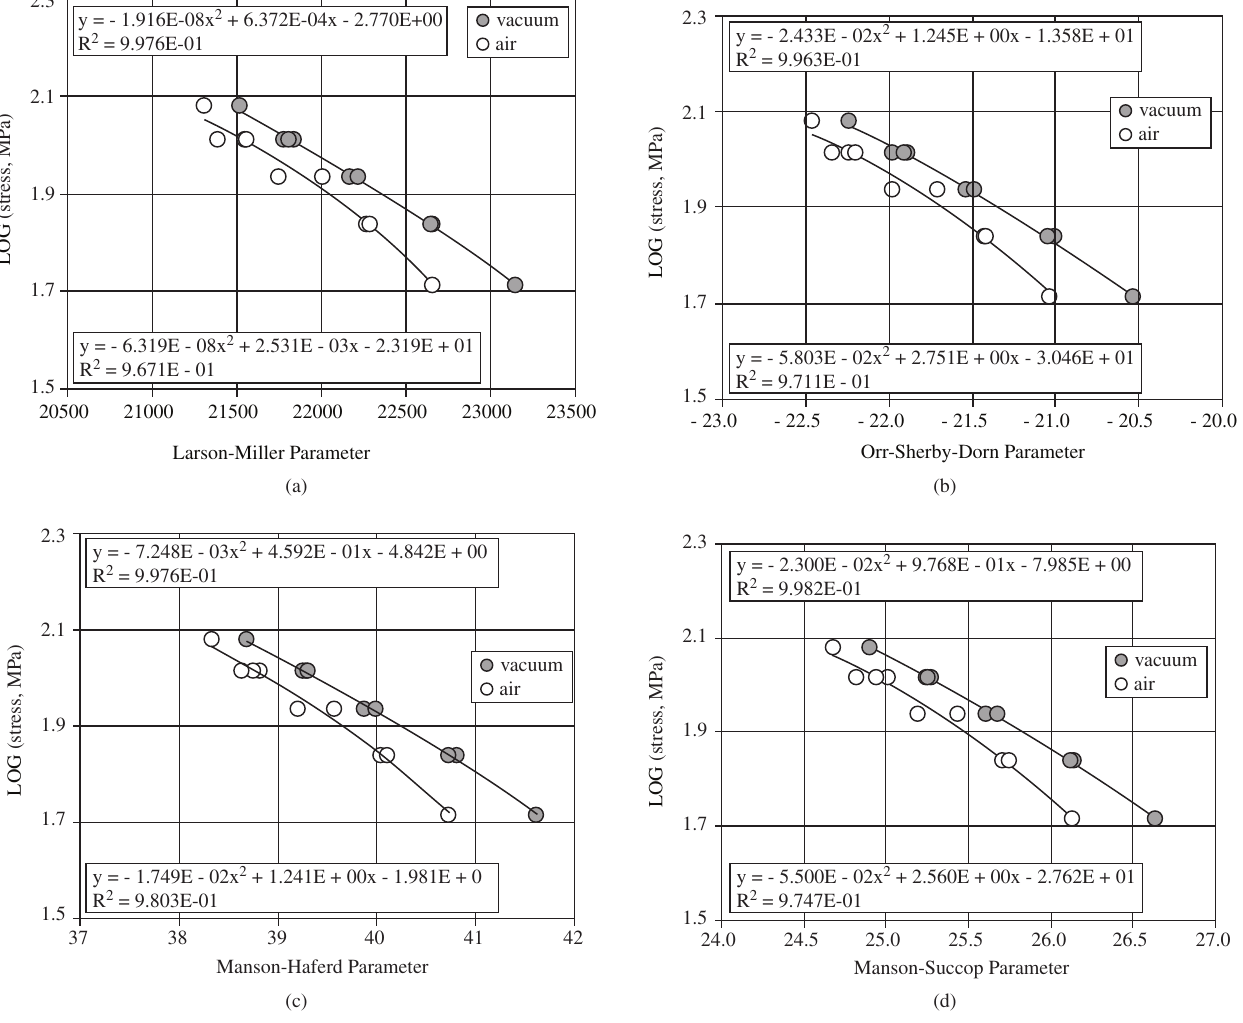
Figure 11. Parameterization curves for 2.25Cr-1Mo steel in air and vacuum according to different methodologies: a) Larson-Miller; b) Orr-Sherby-Dorn; c) Manson-Haferd; and d) Manson-Succop.